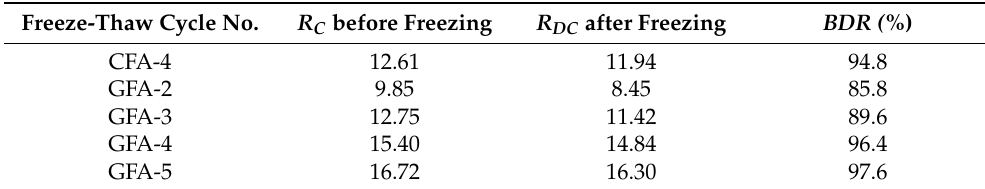
Table 5. Results of freeze-thaw test.